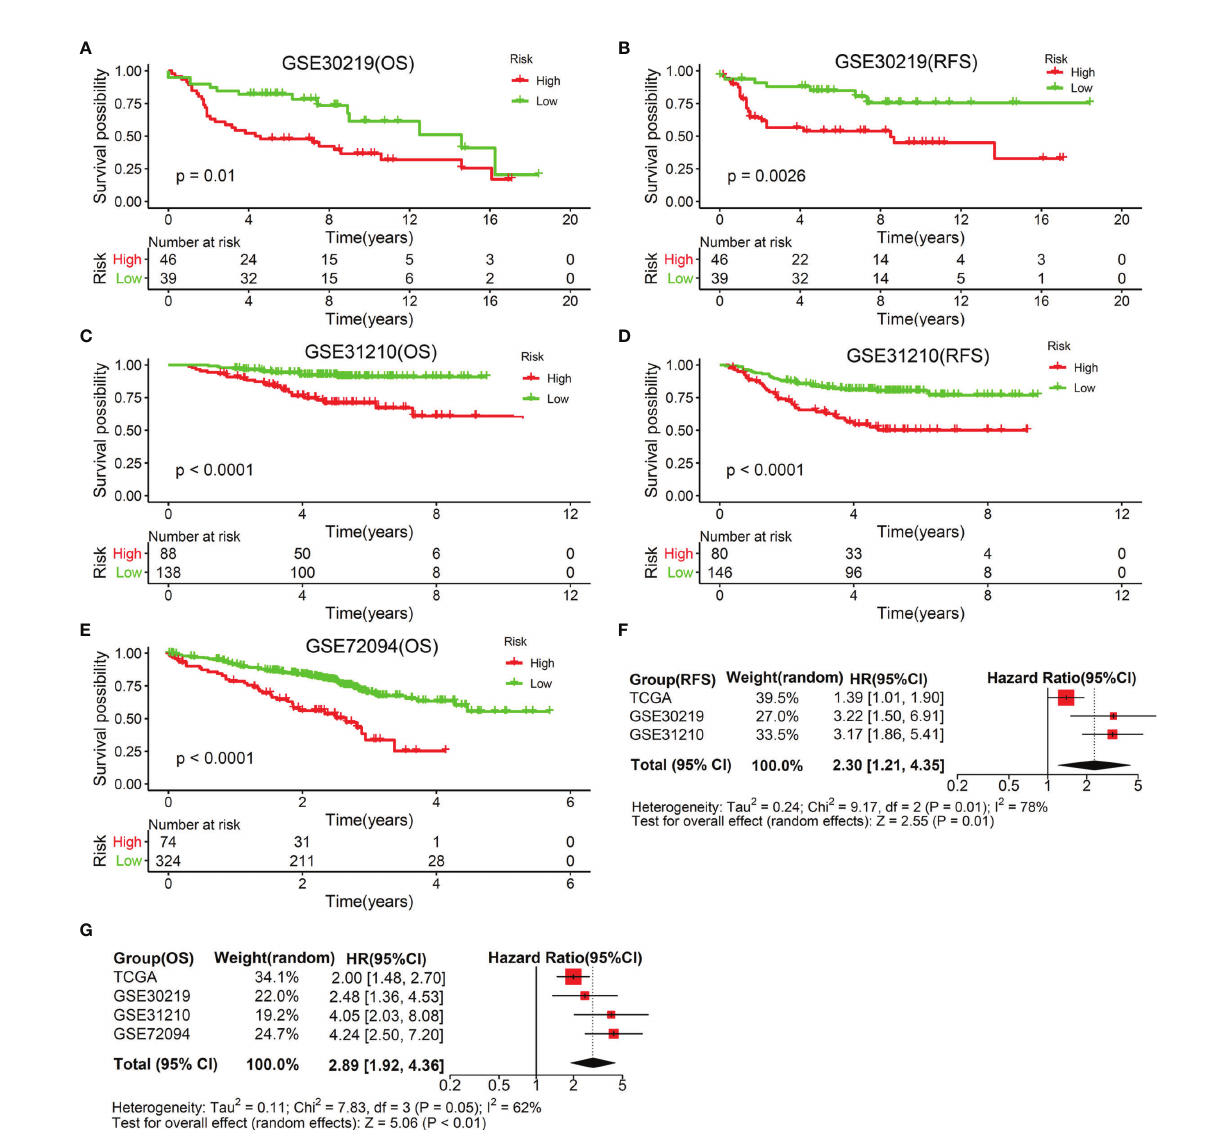
FIGURE 3 | Validation of the predictive value of this TMEM-based signature by another three independent cohorts. OS (A) and RFS (B) analysis for the two risk patterns based on 85 LUAD patients collected from GSE30219 cohort. OS (C) and RFS (D) analysis for the two risk patterns based on 226 LUAD patients derived from GSE31210 cohort. (E) OS analysis for the two risk patterns based on 420 LUAD patients collected from GSE72094 cohort. (F) Meta ‐ analysis of RFS prognostic values of this TMEM-based signature for LUAD patients according to 3 cohorts (TCGA, GSE30219, and GSE31210). (G) Meta ‐ analysis of OS prognostic values of this TMEM-based signature for LUAD patients according to 4 cohorts (TCGA, GSE30219, GSE31210, and